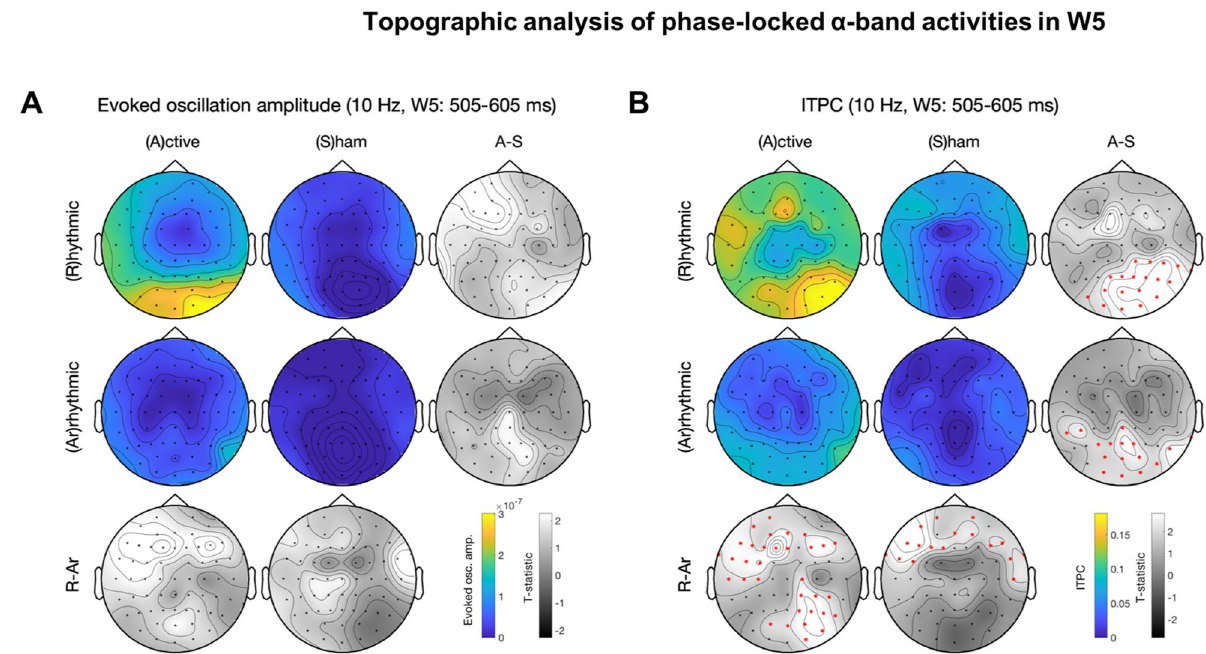
Figure 4. Topographic analysis of phase-locked α-band activities in W5. See figure for panel layout description. ( A ) Evoked oscillation amplitude. ( B ) ITPC. Rhythmic-active stimulation elicits widespread activation. Note that ( B ) continues to show significant difference between conditions whereas ( A ) does